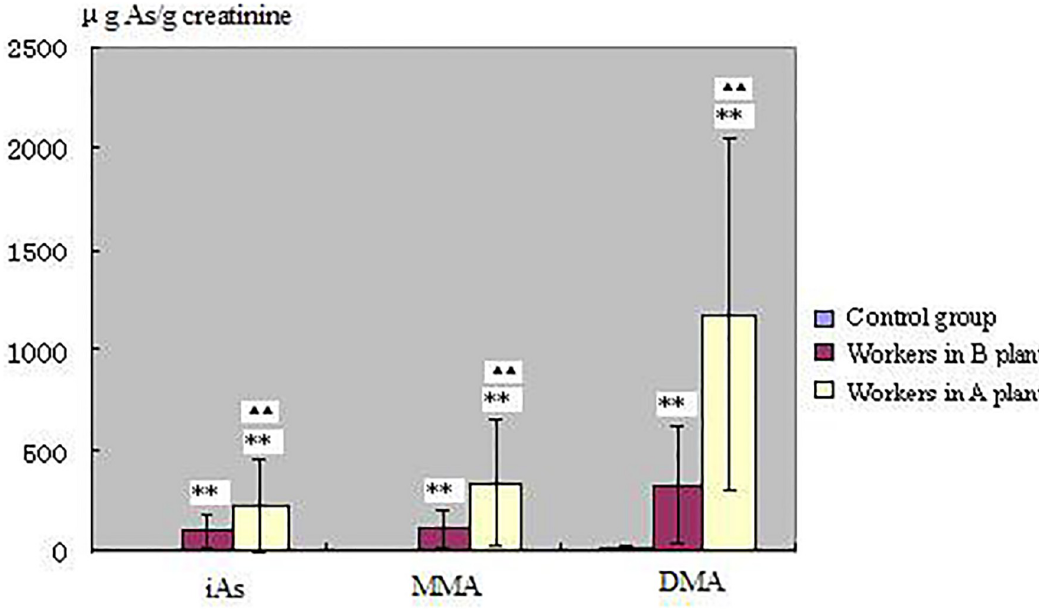
Fig 1. Urinary inorganic arsenic (iAs), monomethylarsonic acid (MMA) and dimethylarsinic acid (DMA) of subjects. Double stars( �� ) indicate that the difference from control group is statistically significant( P < 0.01), double stars( ▲▲ ) indicate that the difference from workers who stopped exposure to arsenic about 85 days (in B plant) is statistically significant( P < 0.01). Workers who smelt arsenic are in A plant.